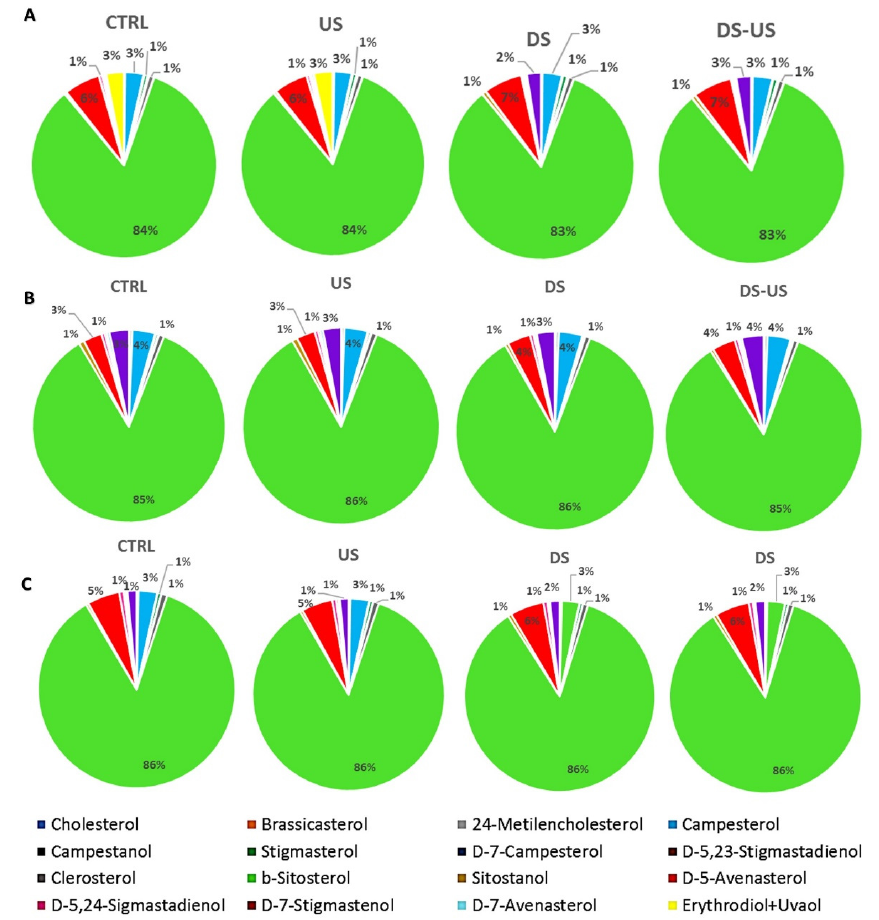
Figure 2. Sterol composition (%) of Peranzana ( A ), Canino ( B ) and Coratina ( C ) EVOOs, treated by the different processes (CTRL = control test, US = ultrasound test, DS = destoned test, DS-US = destoned-ultrasound test). As expected for virgin olive oil, the main sterols found were apparent β -sitosterol, β - sitosterol, D-5-avenasterol, and campesterol, (94.8 ± 0.5%, 87.4 ± 1.1%, 5.2 ± 1.4%, and 3.5 ± 0.4%, respectively), although in different concentrations among cultivars (Peranzana: 94.8 ± 0.2%, 86.0 ± 0.5%, 6.6 ± 0.3%, 3.4 ± 0.2%; Canino: 94.2 ± 0.1%, 88.4 ± 0.2%, 3.6 ± 0.4%, 4.0 ± 0.1%, and Coratina: 87.7 ± 0.1%, 95.4 ± 0.2%, 5.6 ± 0.2%, and 3.1 ± 0.1%) and regardless of the processing process on average no significant differences were observed. However, for the cultivar Peranzana, the content of these compounds was remarkably lower when de-stoning was applied. In addition, for campesterol, all the samples analyzed did not exceed the upper limit of the 4% set by the EU (Regulation 2568/91/EEC and later amendments). As regards the other authenticity indices established by current legislation, the apparent β -sitosterol content was lower than the legal minimum of 93% in all samples examined. All samples also exceeded the upper limits for cholesterol, brassicasterol, and D-7-stigmastenol, although these are minor components in the sterol fraction indifferently to the transformation process. The mean percentage content of triglyceride composition determined in the three cultivars subjected to different processing is depicted in Figure 3A–C.